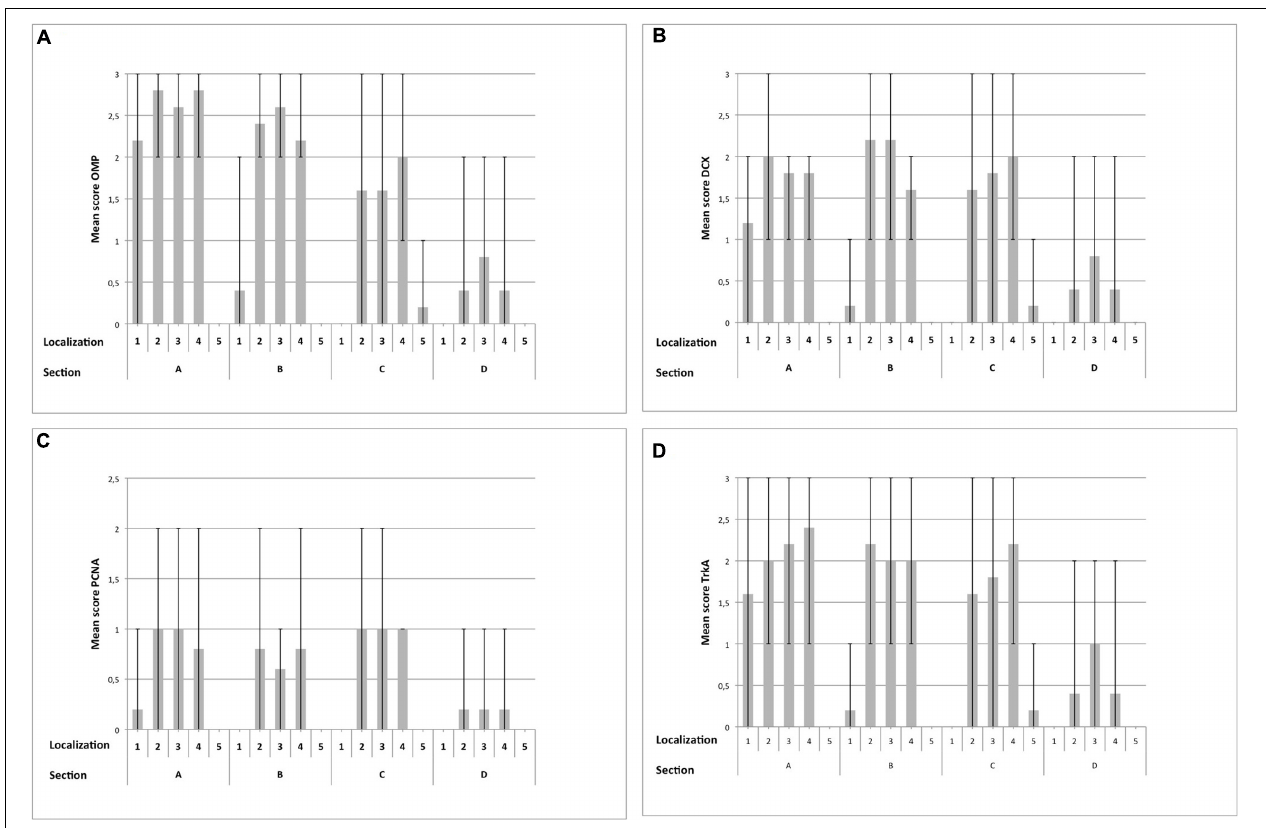
FIGURE 7 | Immunohistological detection of OMP (A), DCX (B), PCNA (C) and TrkA (D) for sections containing OE (A–D), split up for localizations 1–5; (1) nasal septum, (2) dorsal, (3) mid, (4) ventral part of the nasal turbinates, (5) lining of the nasal cavity; bar: arithmetic mean; error bars: minimum/maximum